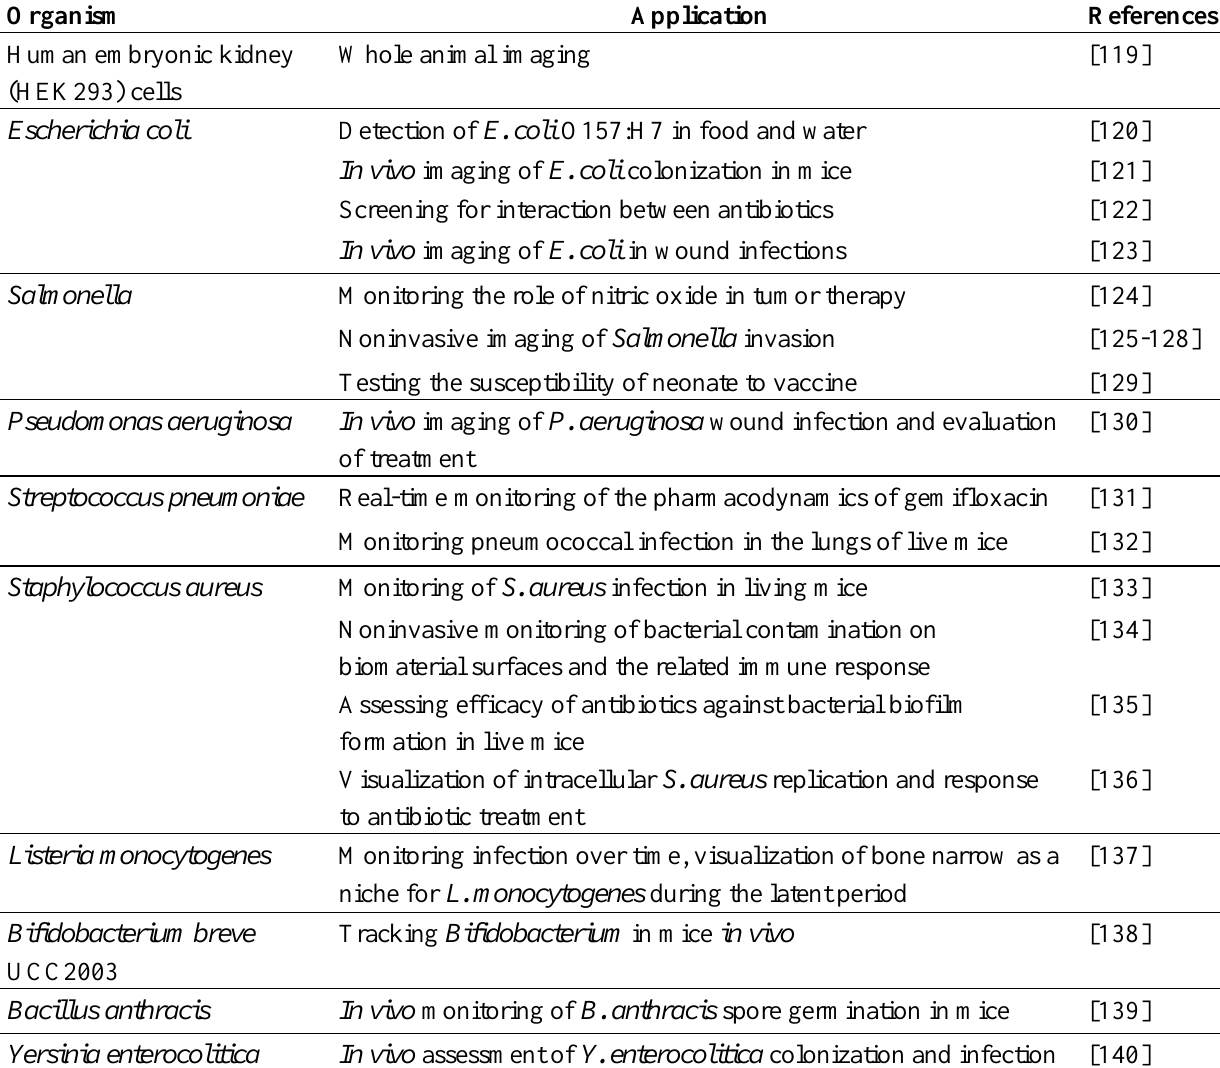
Table 4. Selected BLI applications of bacterial luciferase